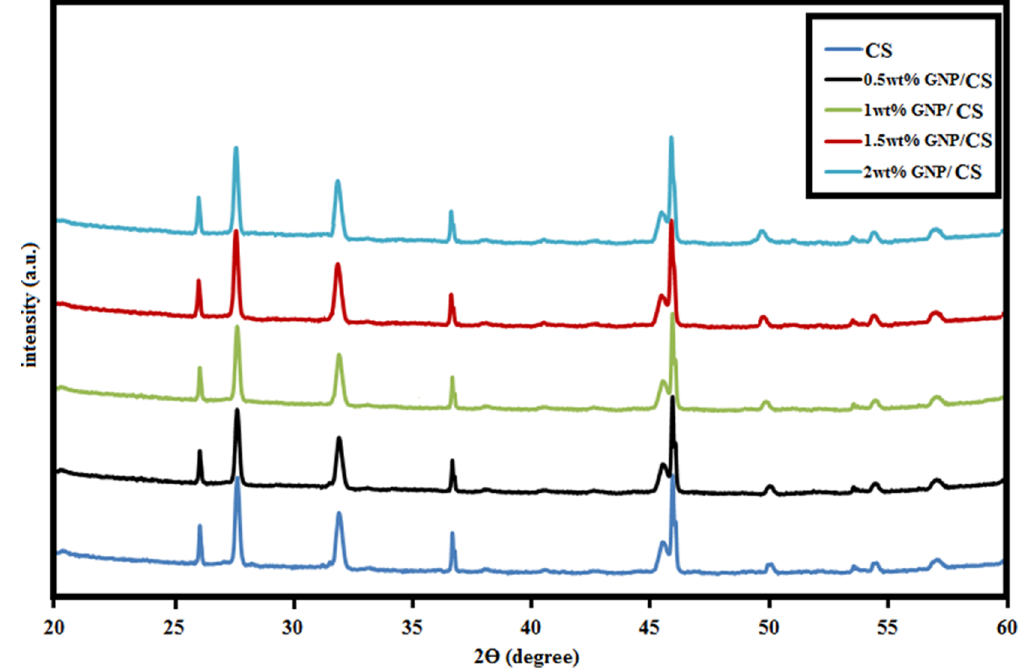
Figure 2. XRD results of pure CS and GNP/CS composites sintered at 1150 6 C by HIP.